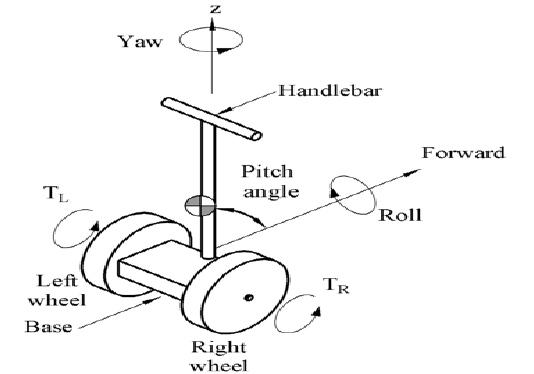
Fig. 1: Schematic Diagram of Two Wheeled Segway (TWMR) are addressed in [7-8]. Issues related to selection of sensors and actuators, control